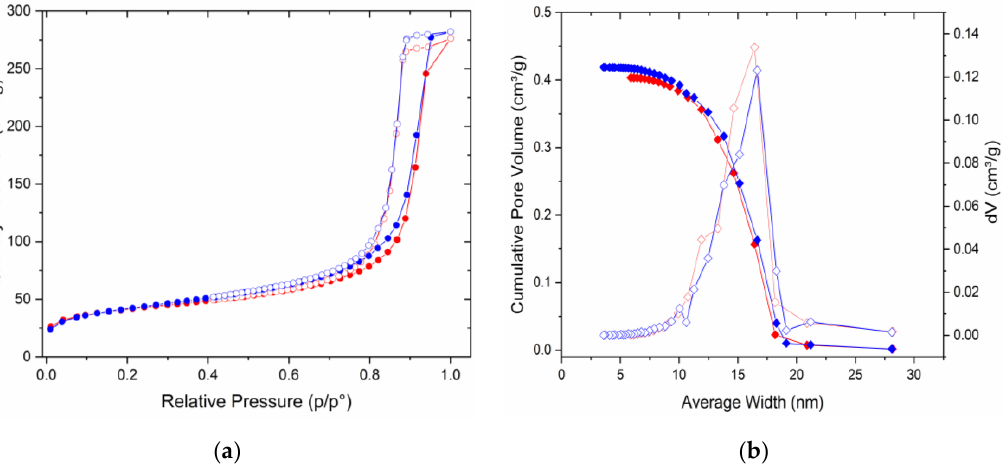
Figure 4. ( a ) N 2 adsorption (filled circles) and desorption (empty circles) isotherms for GSLP-Fe(0) D2 (red) and GSLP-Fe(0) D2 chromium desorption and Fe(0) regeneration (blue). T = 77 K. ( b ) Pore size distribution (hollow diamonds) and cumulative pore volume (filled diamonds) for GSLP-Fe(0) D2 (red) and GSLP-Fe(0) D2 chromium desorption and Fe(0) regeneration (blue). Table 1. Surface parameters of GSLP-Fe, GSLP-Fe(0), and GSLP-Fe(0) after Cr(VI) desorption and Fe(0) regeneration.